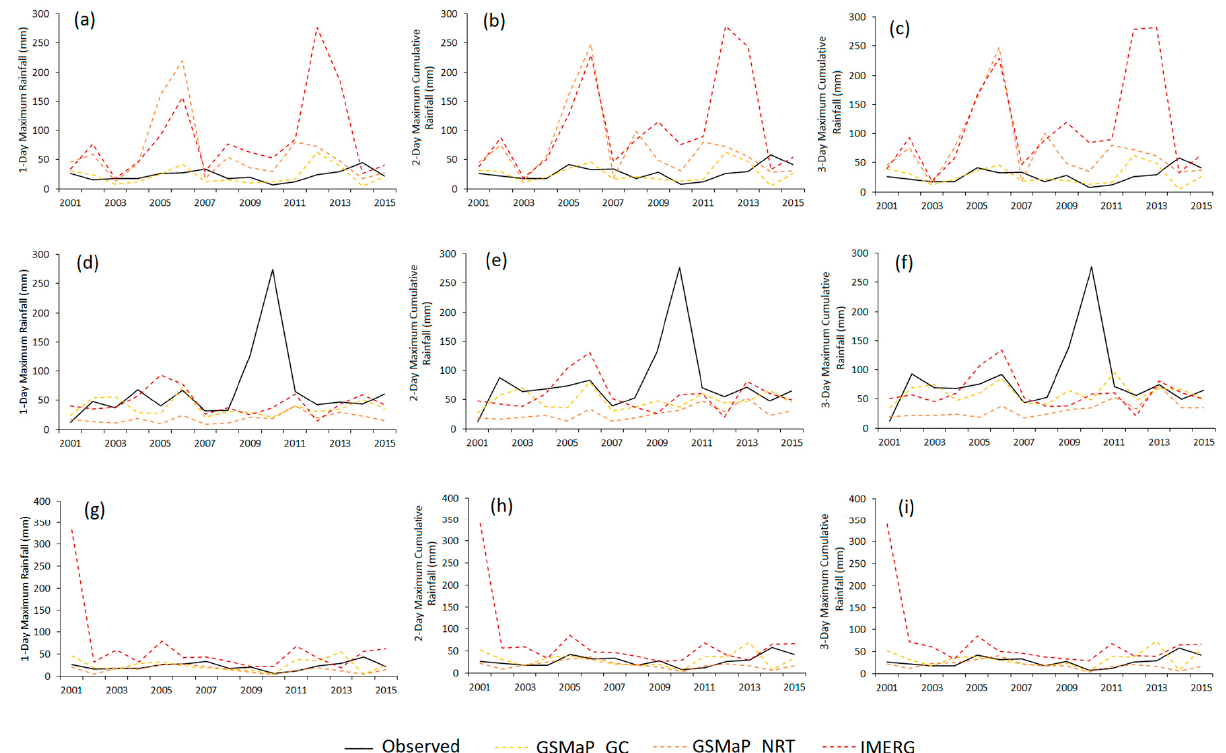
Figure 7. Annual rainfall maxima of in situ and satellite daily rainfall data for 1-, 2-, and 3-days at Baghdad ( a – c ), Mosul ( d – f ), and Basrah ( g – i ).